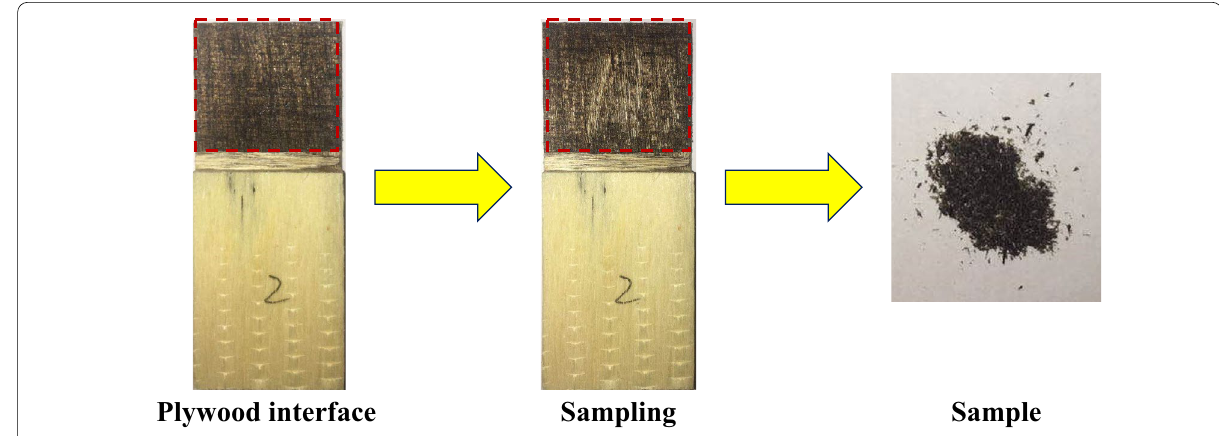
Fig. 2 Schematic illustration of sampling for analyzing the adhesion mechanism